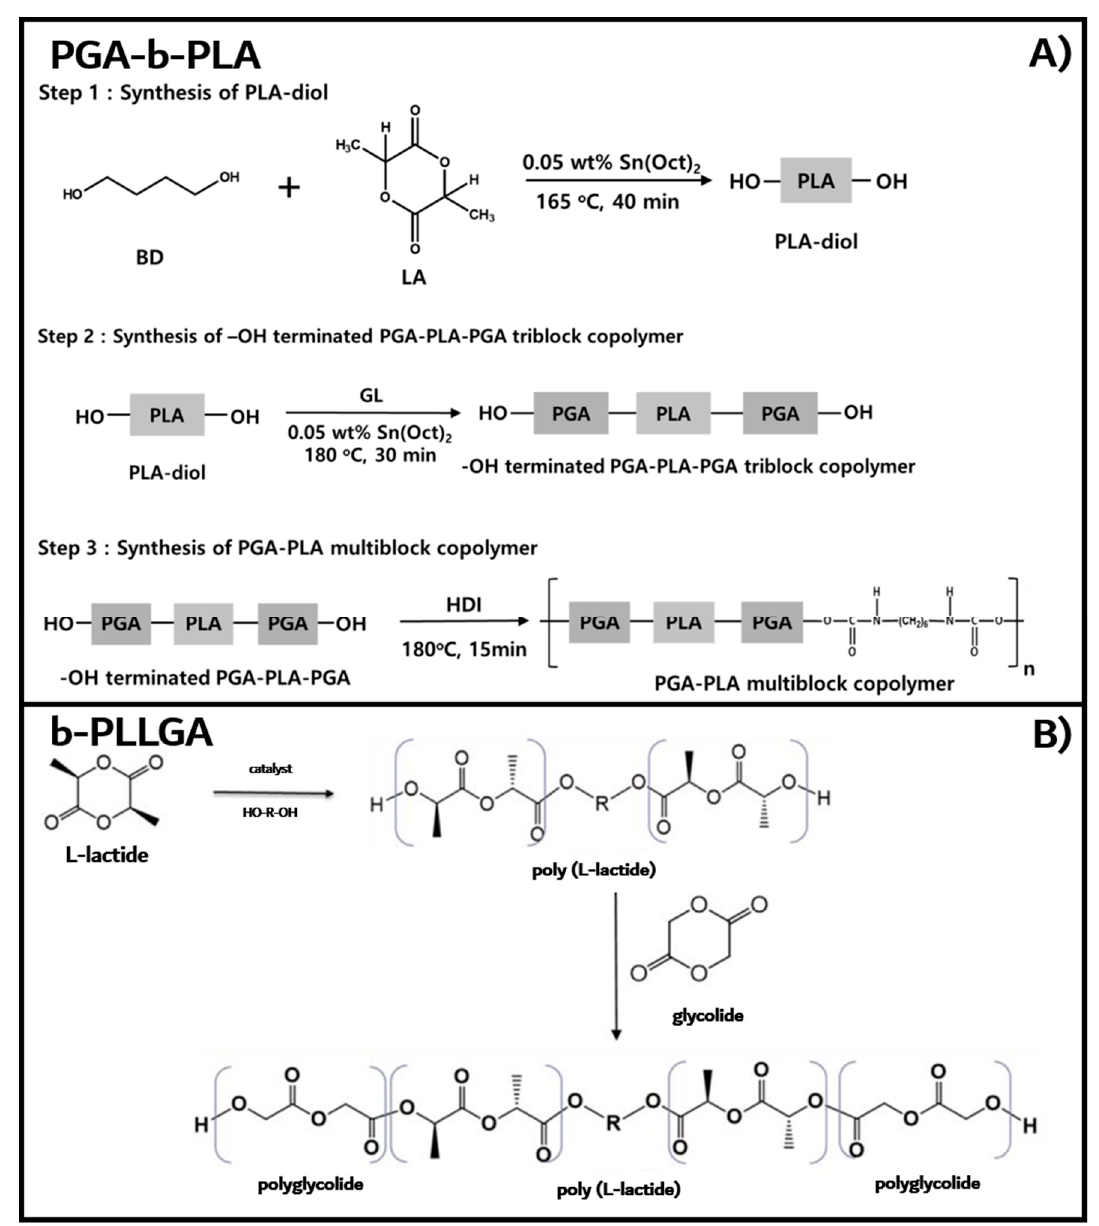
Figure 1. Synthesis of the PGA–PLA multiblock (poly(glycolic acid-b-lactic acid)—PGA–b-PLA) ( A ) and PGA–PLA triblock (b-PLLGA) copolymers. ( B ).